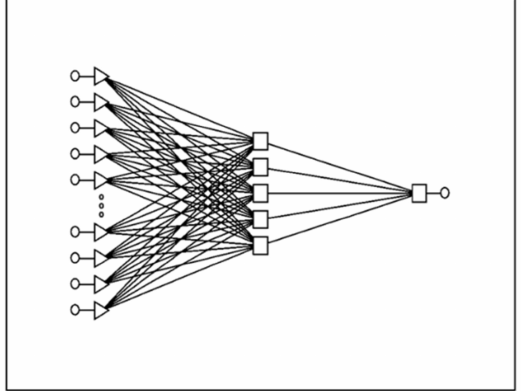
Figure 2. An architecture diagram of the multilayer perceptron with five neurons in a single hidden